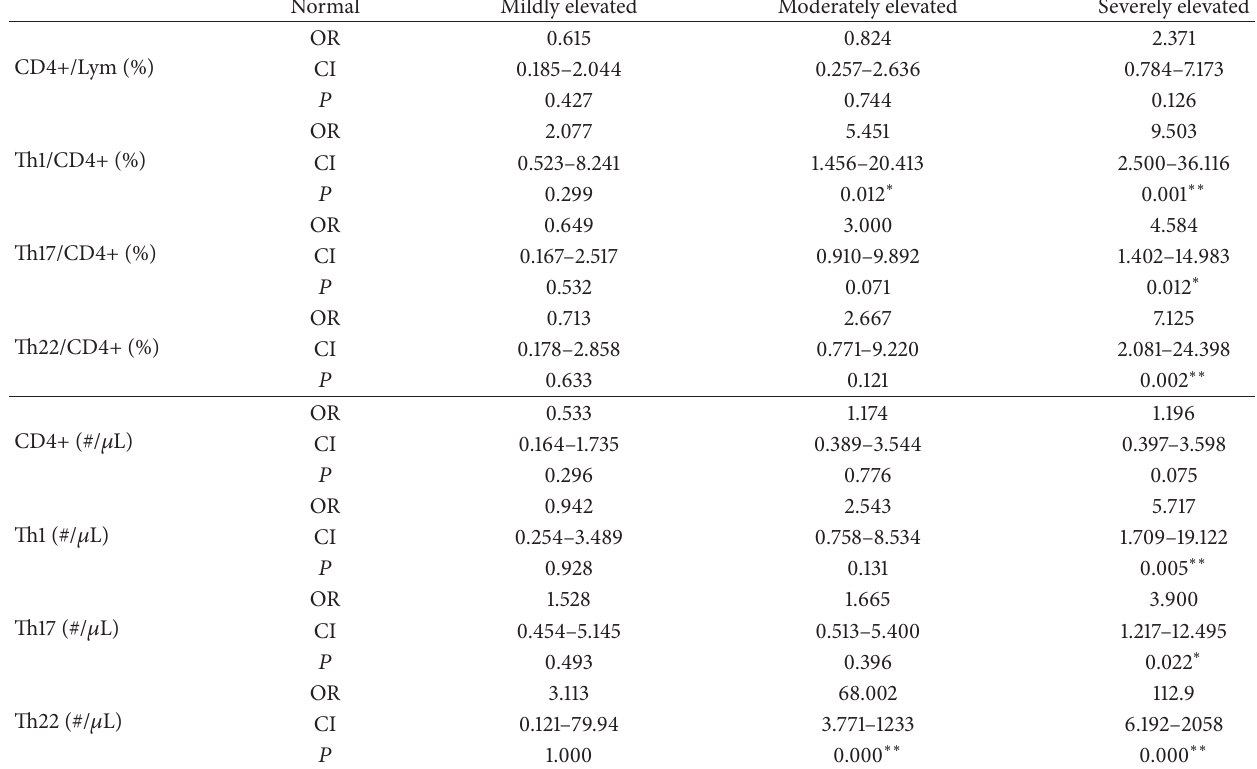
Table 5: Categorical analysis of odds ratios adjusted by age and